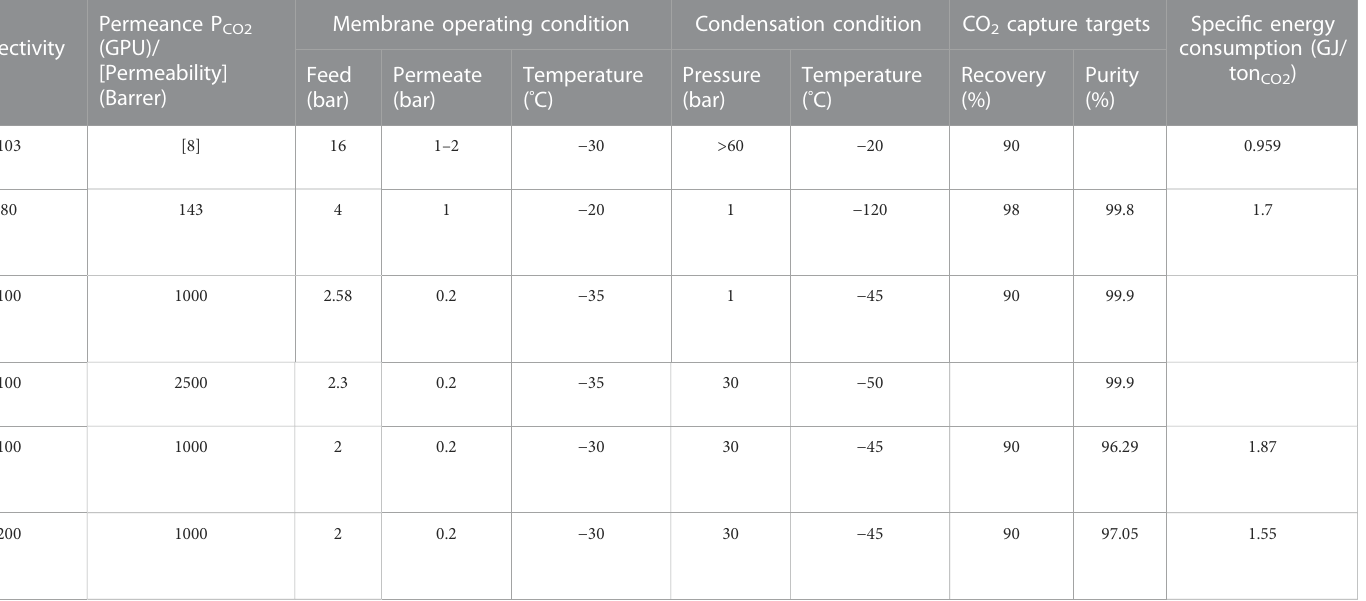
TABLE 2 LTMC process CO 2 capture target and energy penalty